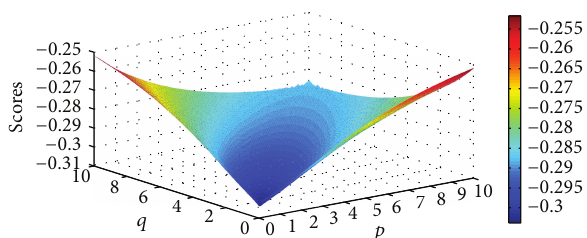
Figure 12: Scores for District 𝐴 4 obtained by the IIFWBM operator (𝑝 ∈ (0, 10],𝑞 ∈ (0,10]) .